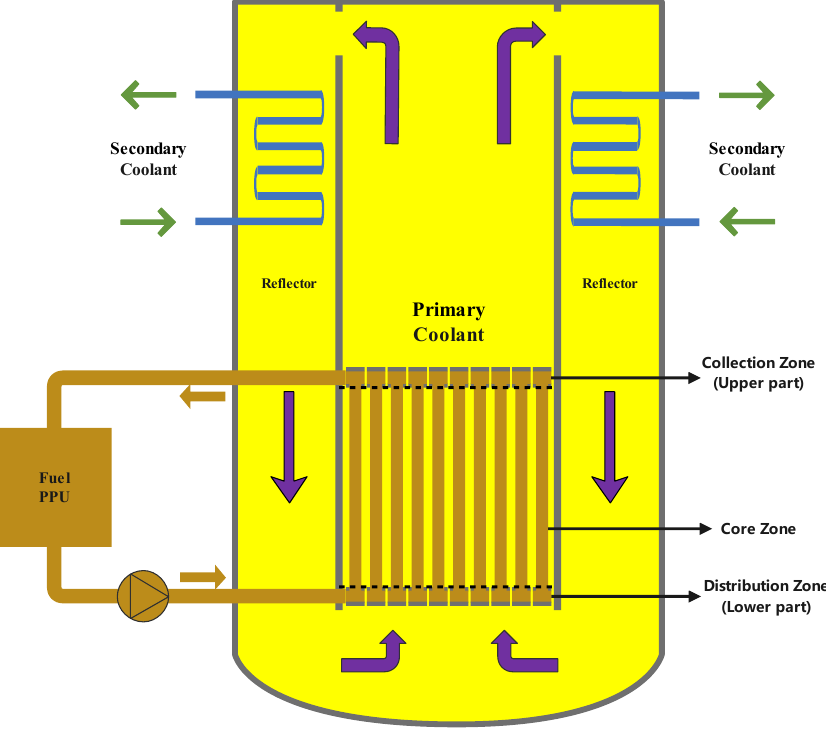
Figure 1. Schematic of the small modular dual fluid